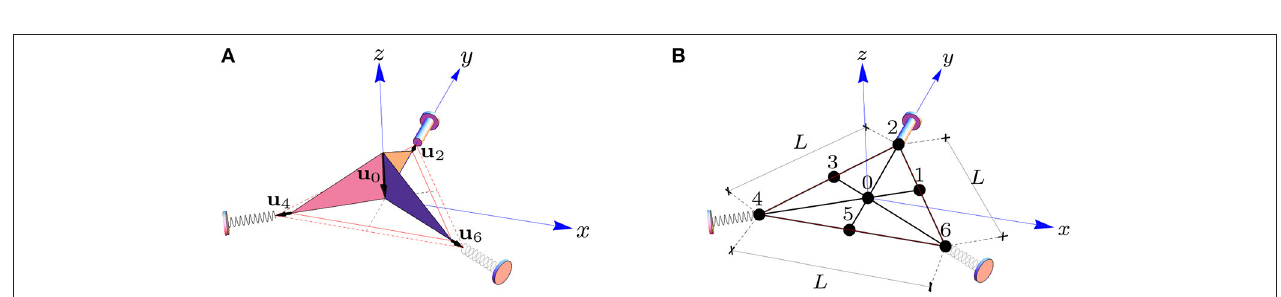
FIGURE 3 | Reference (A) and deformed (B) configurations of a tensegrity model of the TABS module. (A) shows the folded configuration of the structure corresponding to the fully opened screen. (B) depicts the flat configuration (fully closed screen), where the module reduces to an equilateral triangle with side L . Nodes 2, 4, and 6 are mutually connected through deformable strings (red-colored members), which are at rest in the reference configuration, and fully stretched in the flat configuration. The strings are superimposed to the perimeter bars in the flat configuration (B) .